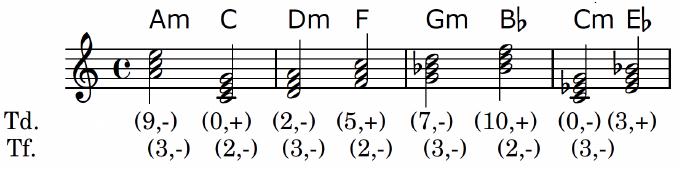
Figure 7. Output example, uniform triadic transformation (UTT)-based method.